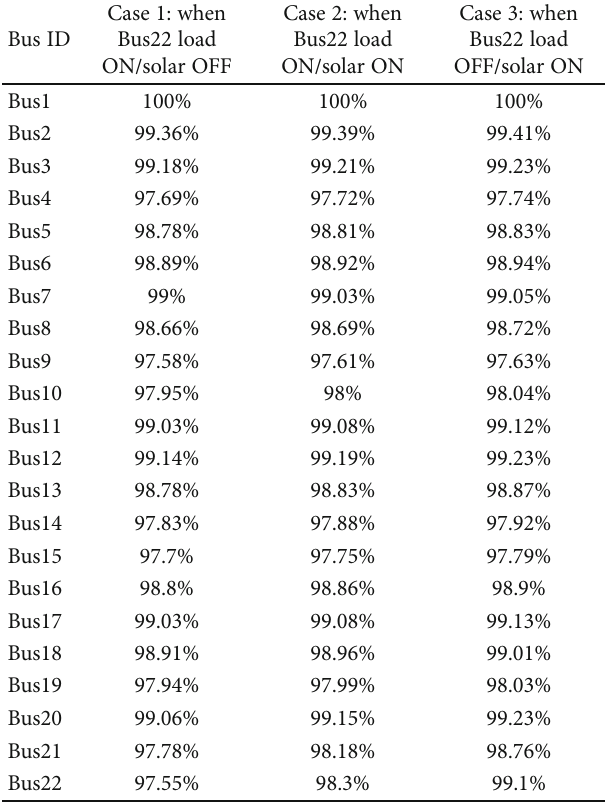
Table 12: Load fl ow of N-M network for Case 2.